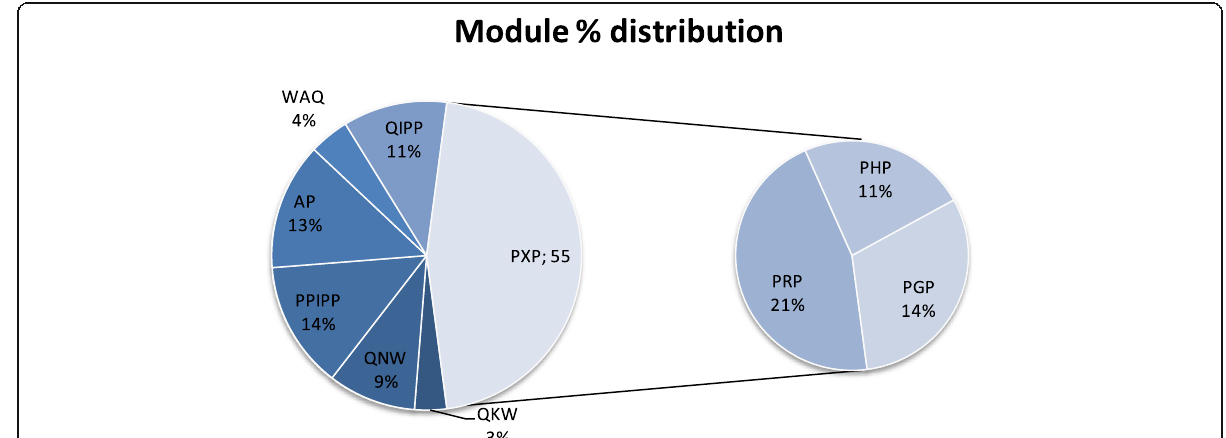
Fig. 3 Percent distribution of the modules identified in snake